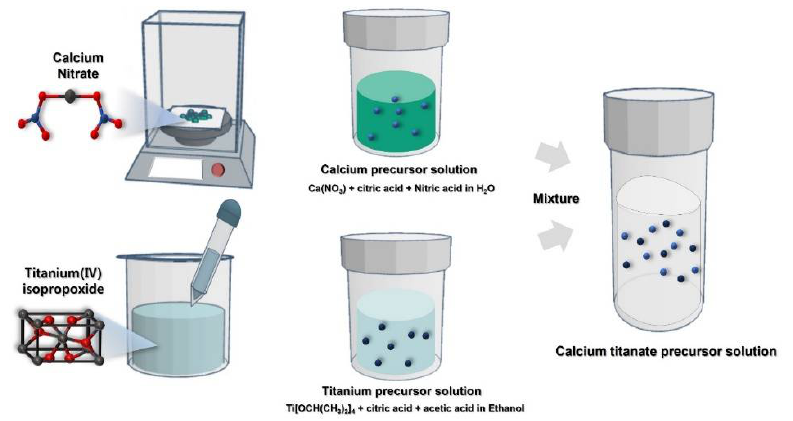
Figure 1. Precursor solution preparation process: the calcium titanate precursor solution was prepared by mixing Ca and Ti solutions at a 1:1 ( v/v ) ratio.